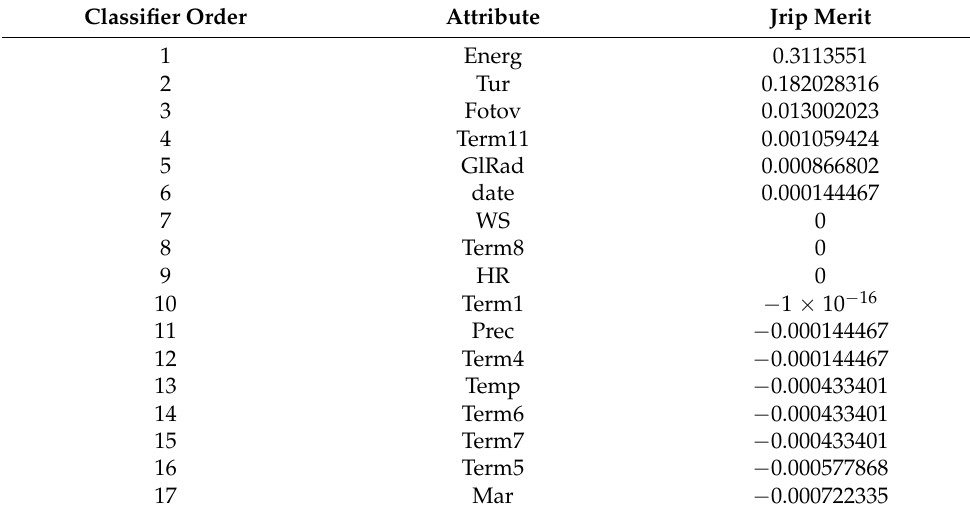
Table 6. Attribute classification evaluator classifier attribute Jrip.